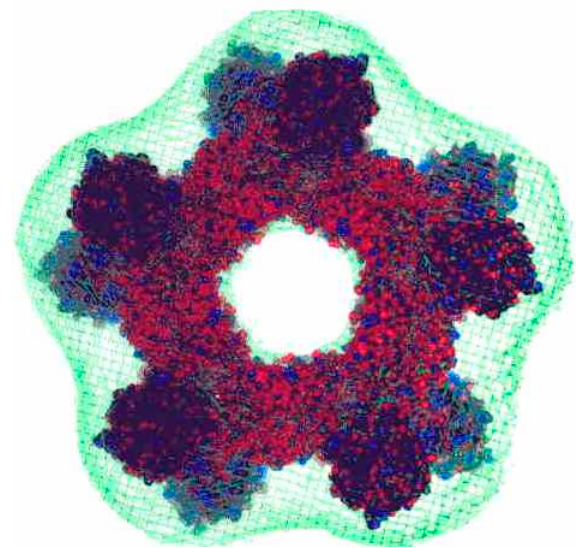
Figure 4. Model of tryparedoxin peroxidase of Trypanosoma brucei brucei loaded with 10 molecules of mutated tryparedoxin. Tryparedoxin peroxidase is a typical 2-Cys-Prx that tends to form donut-shaped decamers consisting of five catalytic units (dimers). Here, the oxidized tryparedoxin peroxidase was reacted with an excess of a tryparedoxin mutant with the C-terminal cysteine of the CPPC motif changed to serine ( Tb TXNC43S). The surface-exposed C40 of the tryparedoxin mutant can still react with the resolving cysteine (C173´) of the peroxidase, but stays attached (protrusions at the donut), because it can no longer fully reduce the peroxidase [139]. The model is based on electron microscopic images as described in detail in [140] and was prepared by H. J.